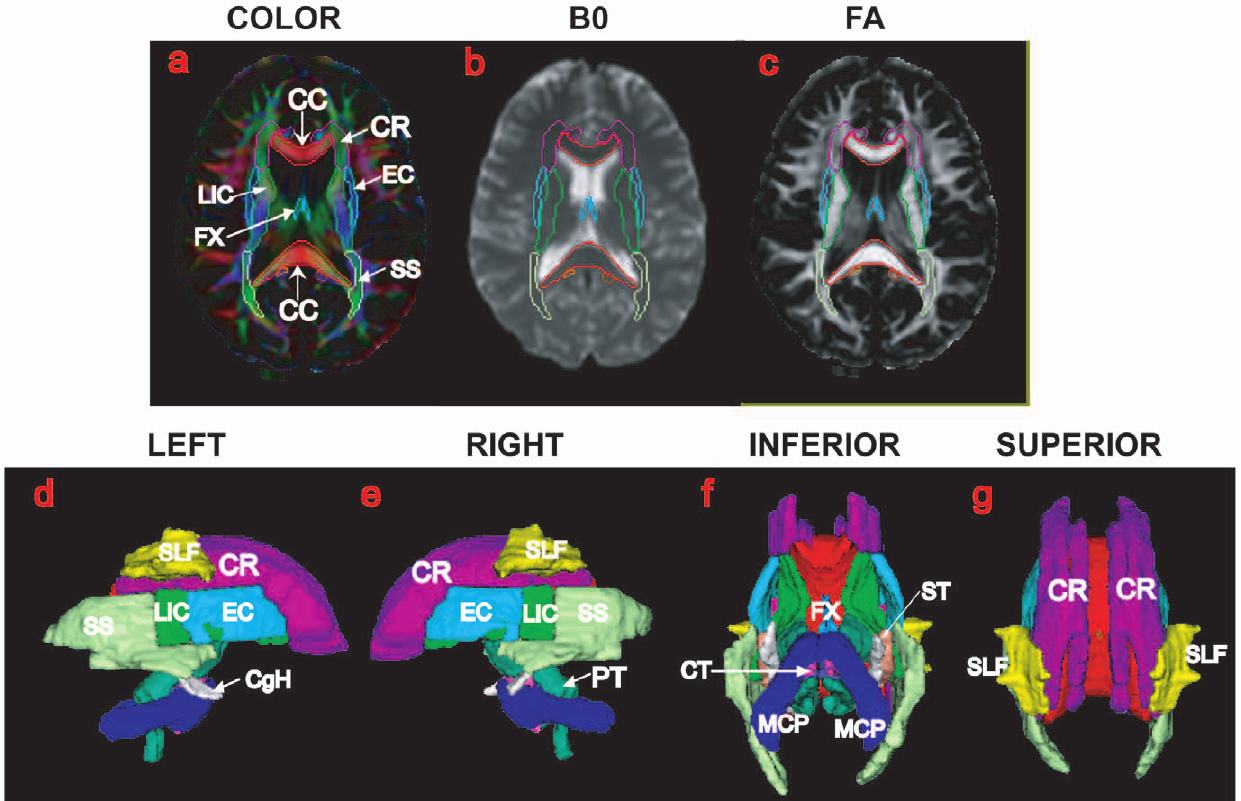
Figure 2. The single-subject atlas of the deep white matter tracts. The top row illustrates the color map, image without diffusion weighting, and fractional anisotropy (FA) with the contours of the deep white matter tracts, respectively. The bottom row shows the surface representation of the deep white matter tracts in the left, right, inferior, and superior views. Each tract surface is color coded. The anatomical definition of each white matter tract was detailed in [20]. The abbreviations of the tracts’ names are given in Text